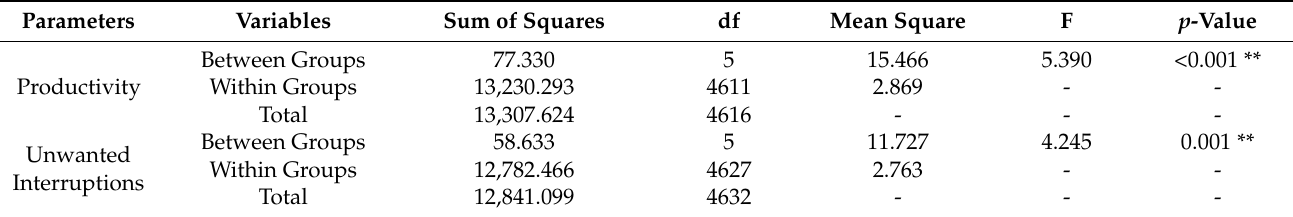
Table 17. One-way ANOVA analysis comparing productivity and unwanted interruptions for different workgroups.